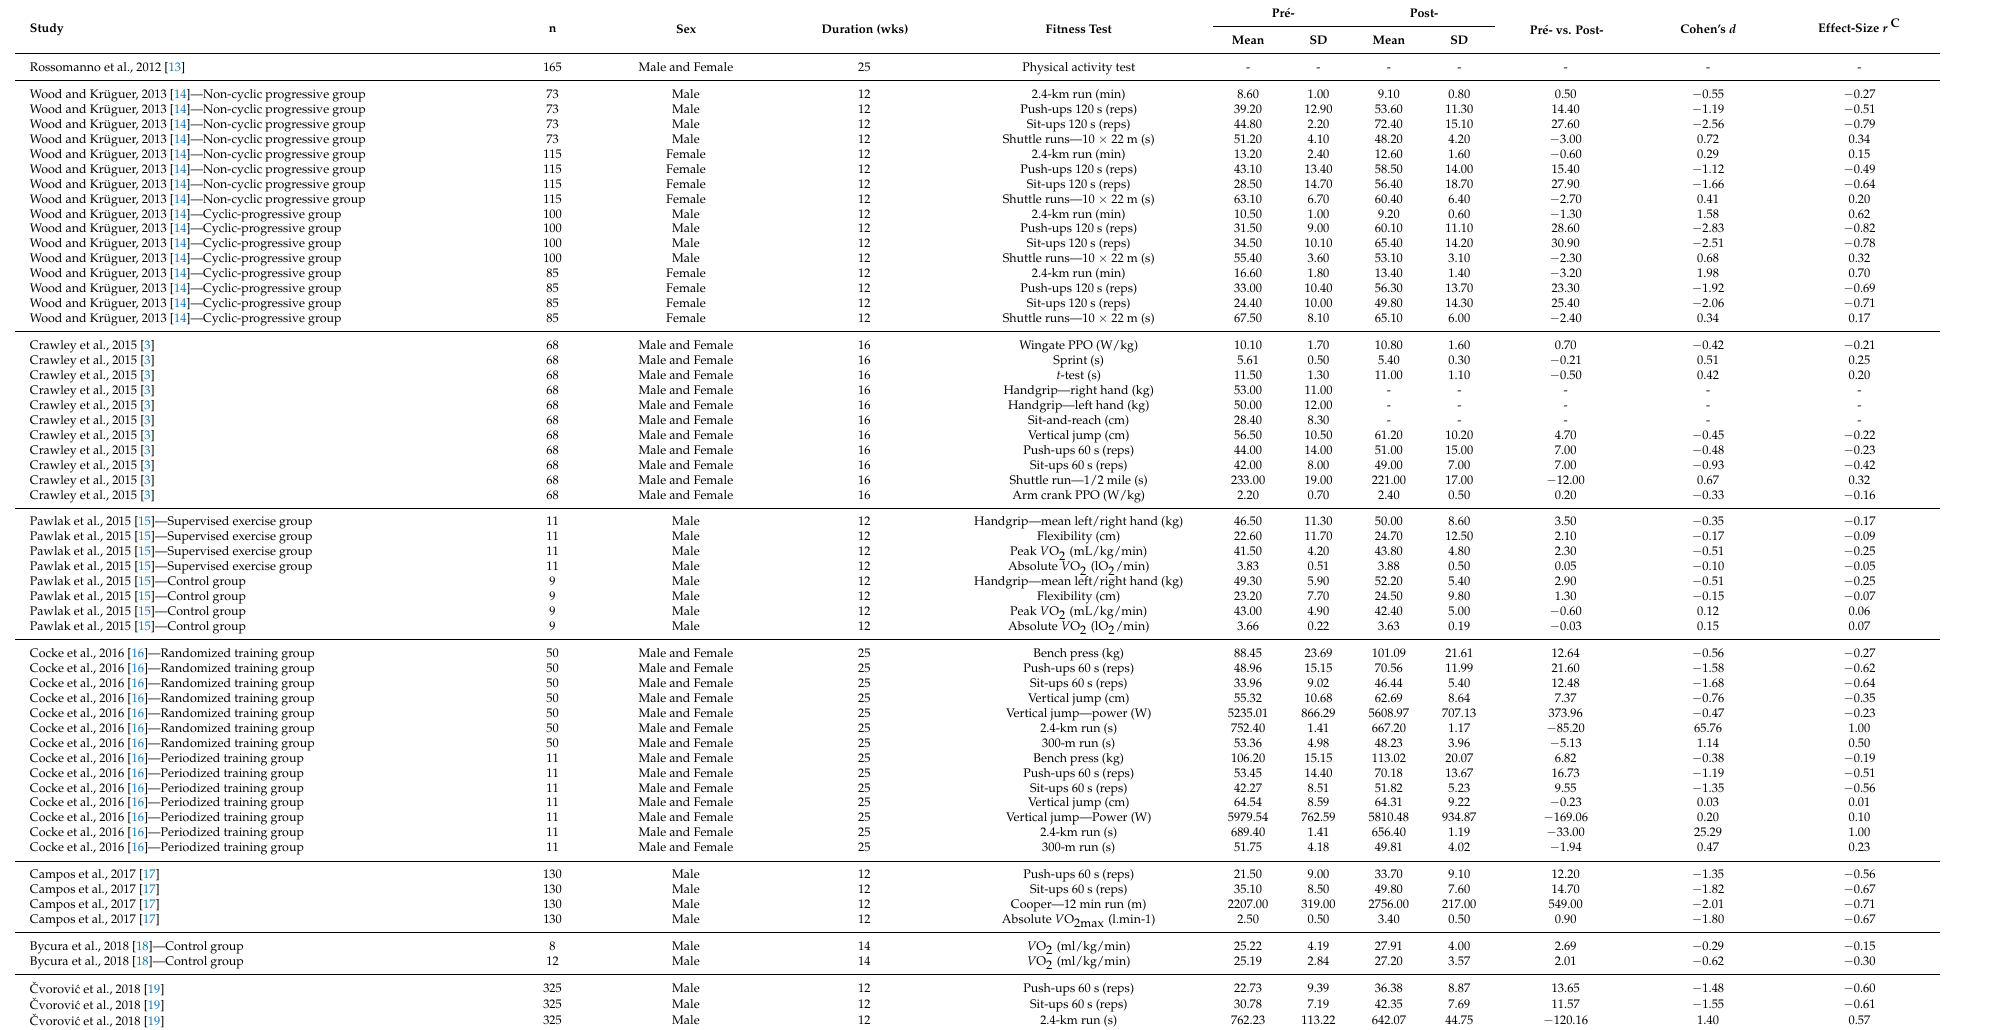
Table 5. Effect size (Cohen’s d ) and effect size correlation ( r ) of physical training programs on fitness